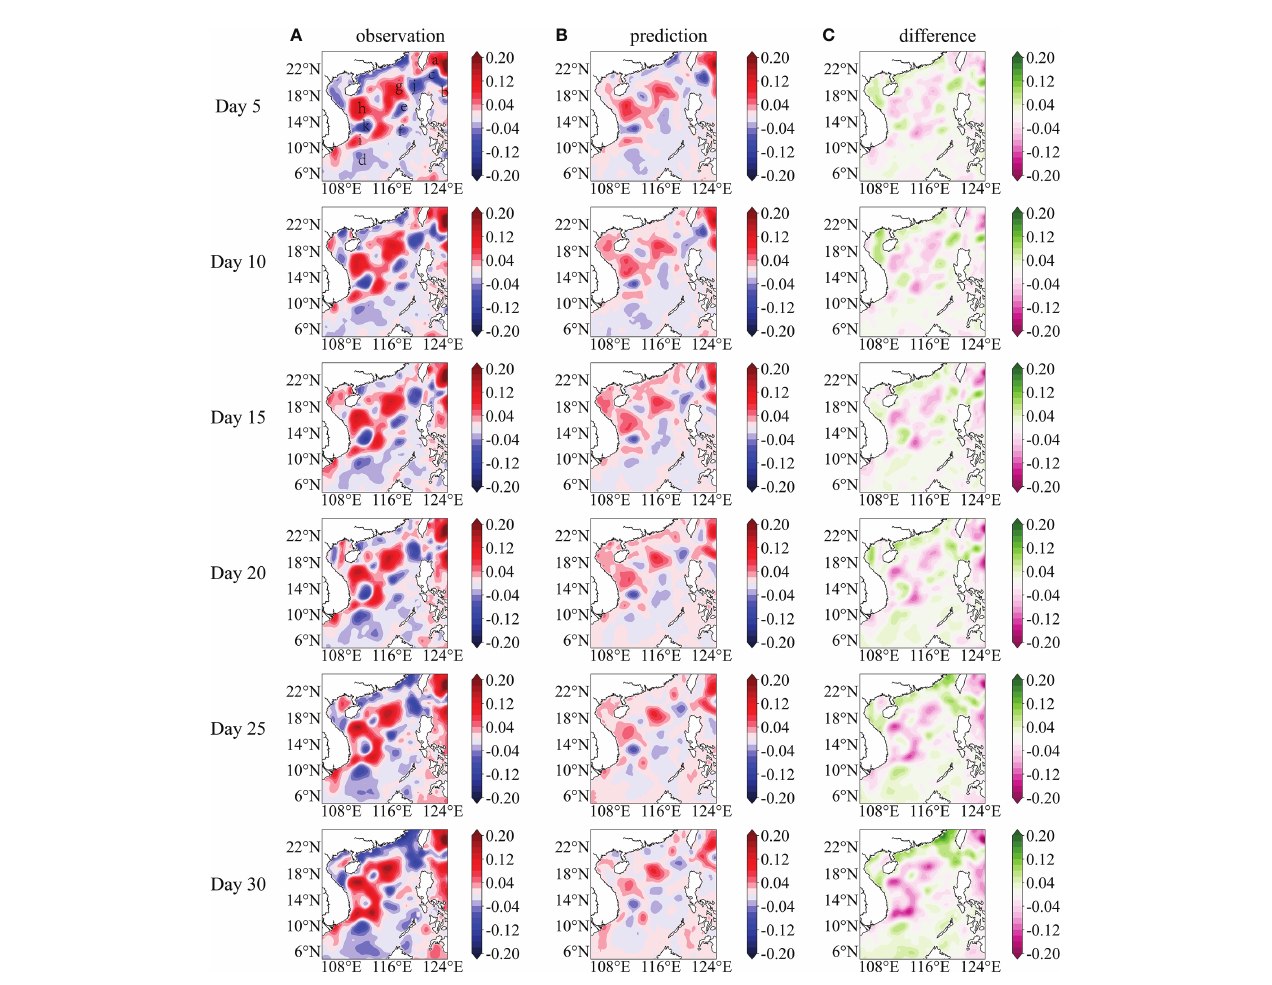
FIGURE 8 Observation (A) , prediction (B) , and difference (C) snapshots of sea surface height anomaly (SSHA, m) prediction for 1 – 30 days (interval of 5 days), corresponding to June 14 to July 13, 2020.